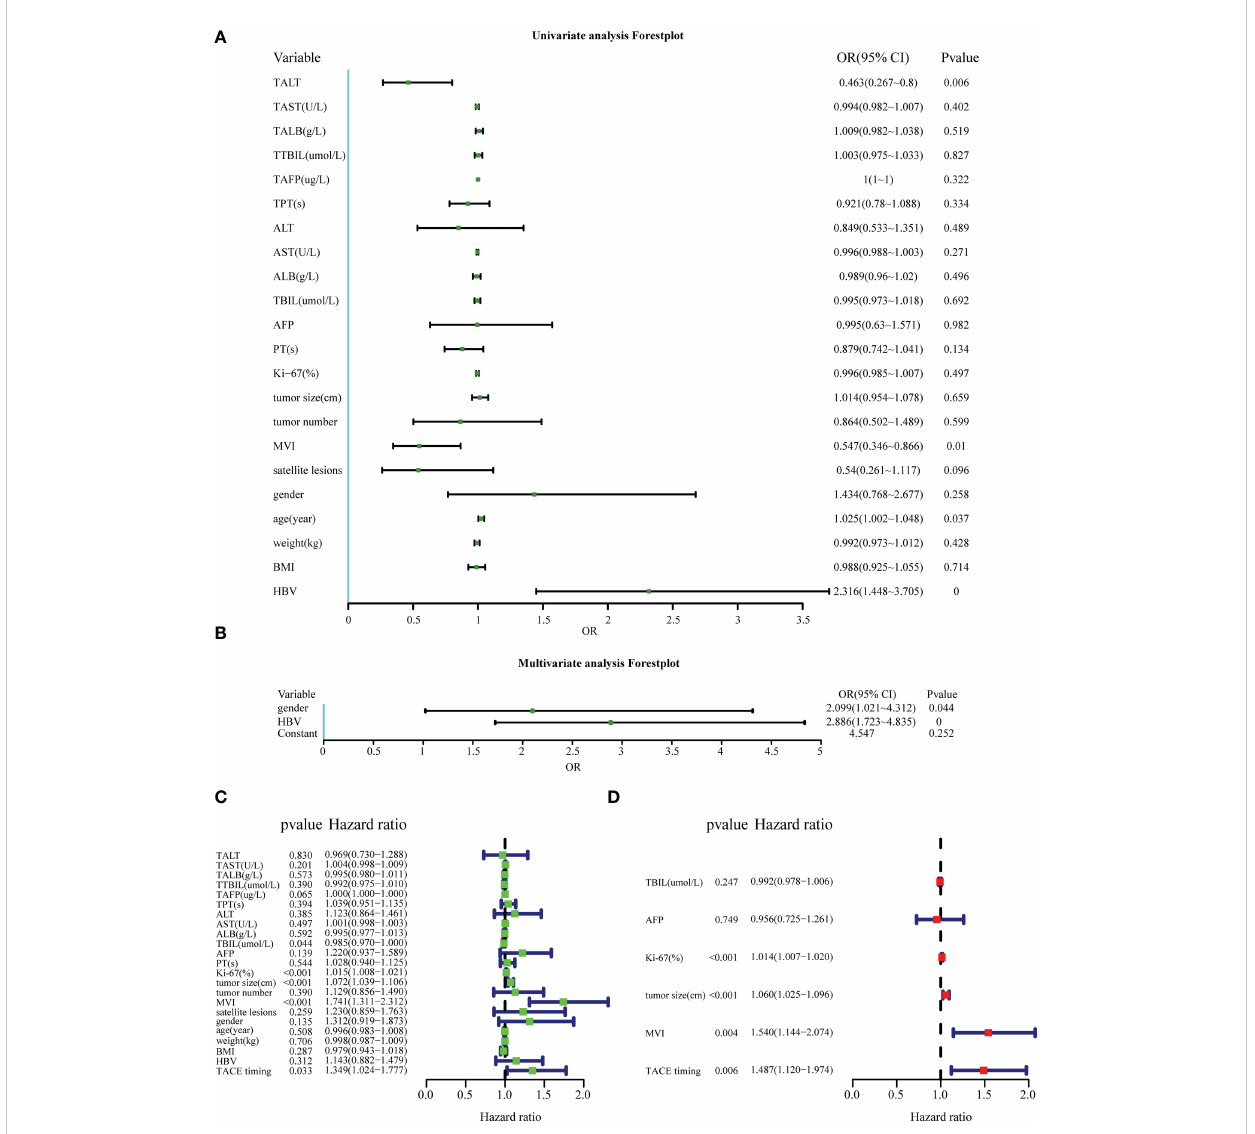
FIGURE 3 Factors affecting the PA-TACE timing and the prognosis of HCC. (A, B) Univariate and multivariate logistic analyses to evaluate the factors affecting the PA-TACE timing for RFS. (C, D) Univariate and multivariate Cox analyses to evaluate independent prognostic factors of HCC for RFS. ALT, alanine aminotransaminase; AST, aspartate aminotransferase; ALB, albumin; TBIL, total bilirubin; AFP, serum alpha- fetoprotein; PT, prothrombin time; MVI, microvascular invasion; BMI, body mass index. The indicators before PA-TACE were displayed as “ T + indicators ” , such as “ TALT ”